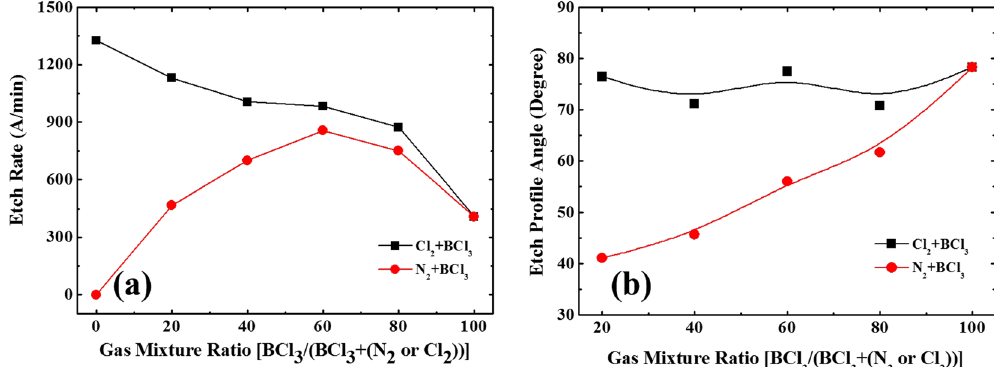
Figure 3. Etching rate and etching profile angle for SiC etching under different gas mixture ratios. ( a ) Etching rate using BCl 3 mixed with Cl 2 (black line) and with N 2 (red line), demonstrating the high etching rate characteristics of BCl 3 + Cl 2 gas mixtures. ( b ) The BCl 3 + N 2 gas mixture (red line) achieves controllable etching profile angles between 40 ° and 80 ° , varying almost linearly with the mixture ratio. In contrast, unstable characteristic is observed for the other gas mixture, BCl 3 + Cl 2 (black